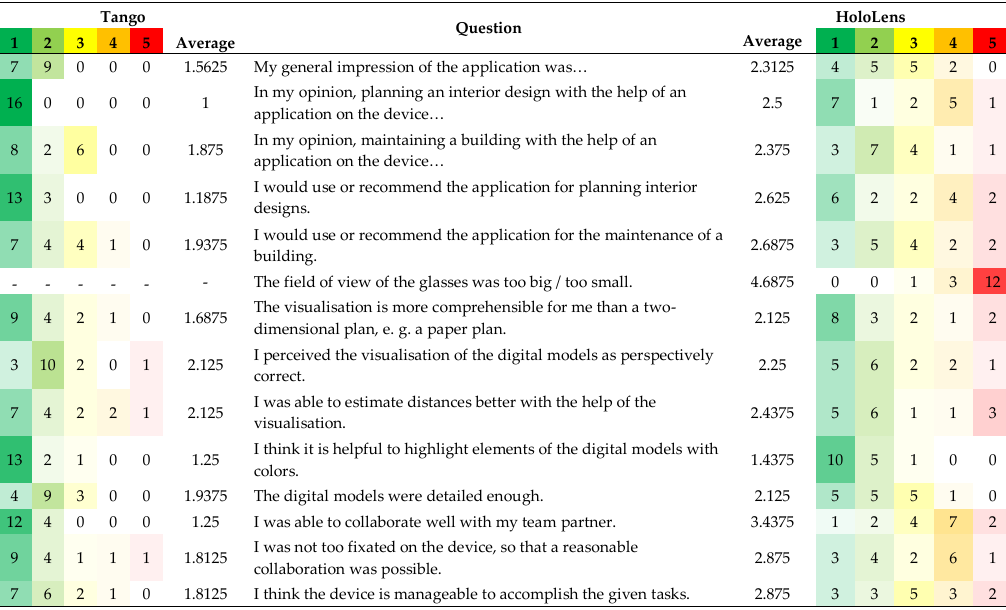
Table 2. Results of the user test ( n = 16)—device specific ratings for Tango and HoloLens. Likert scale ranging from 1 (high) to 5